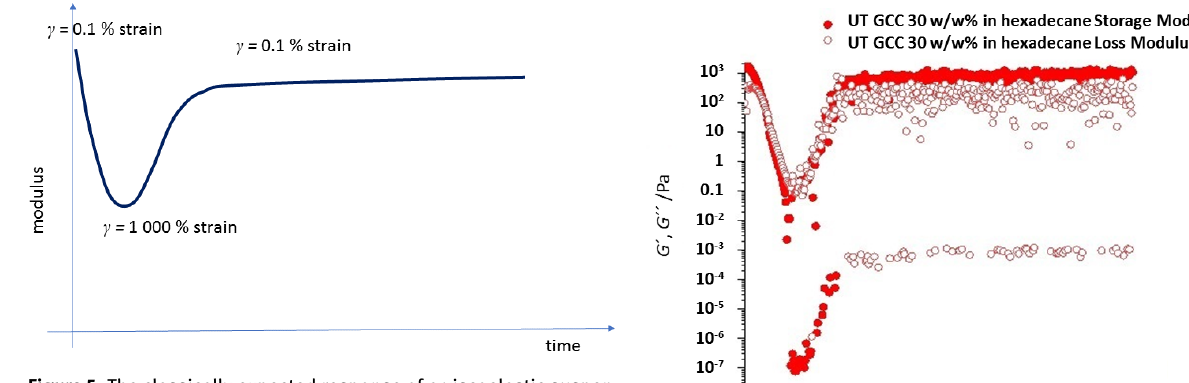
Figure 5: The classically expected response of a viscoelastic suspen- sion showing particle-particle structure interaction, breakdown and recovery, which can be partial only, over time.